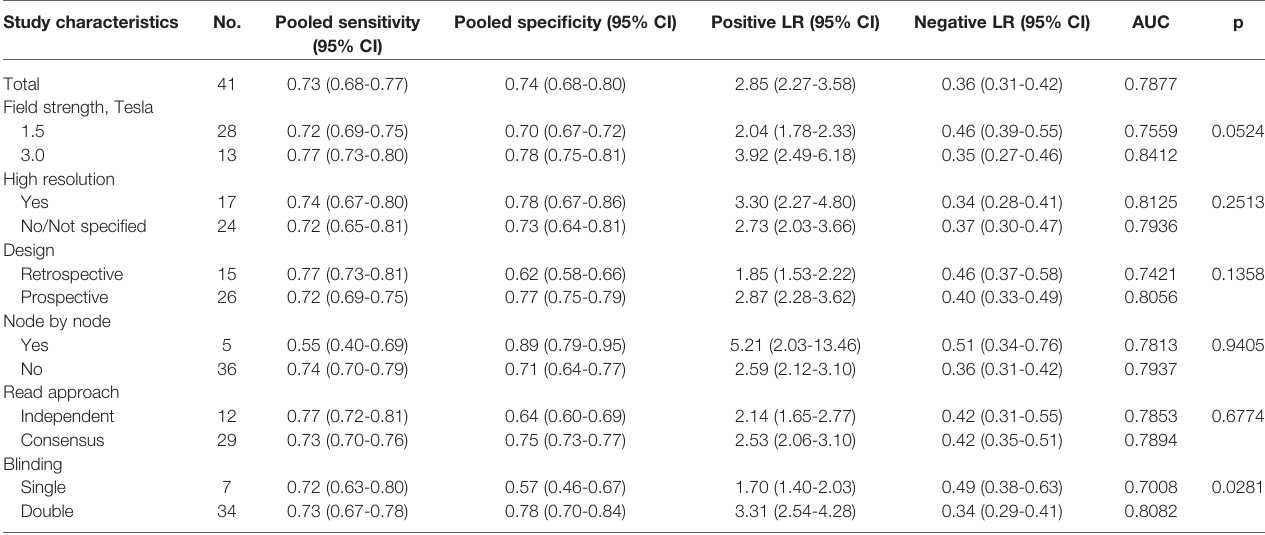
TABLE 4 | Results of subgroup analysis for evaluation of all